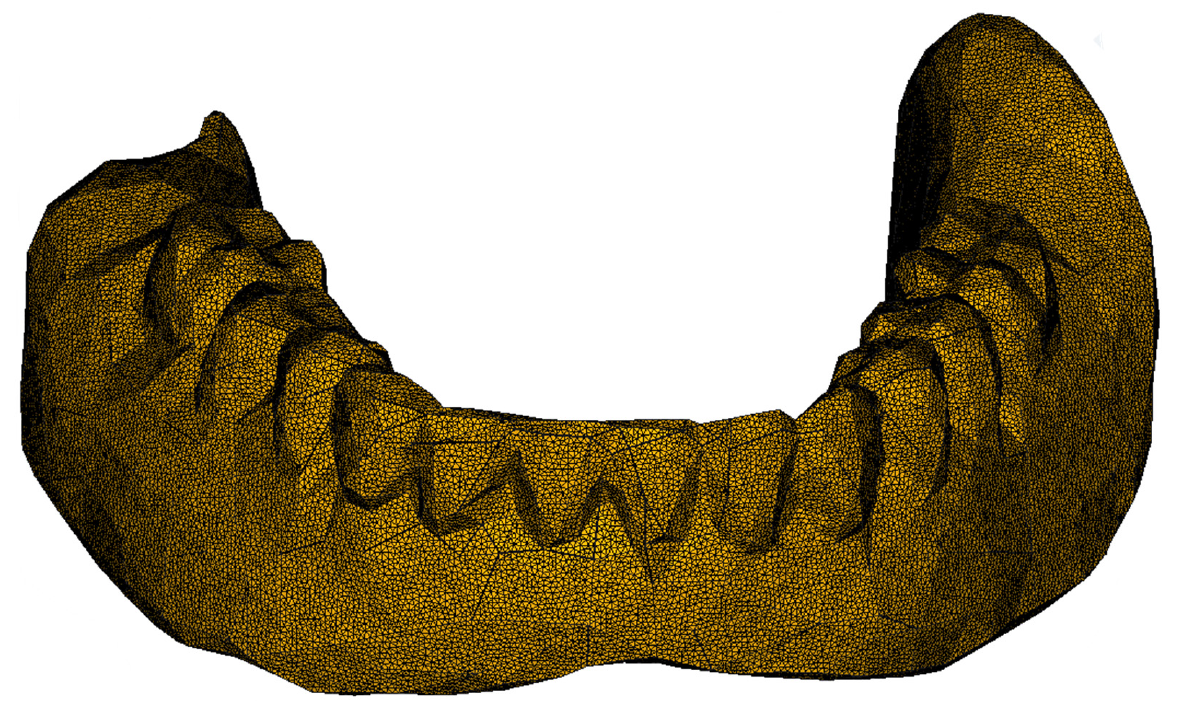
Figure 1. The model of a real mandibular overdenture.